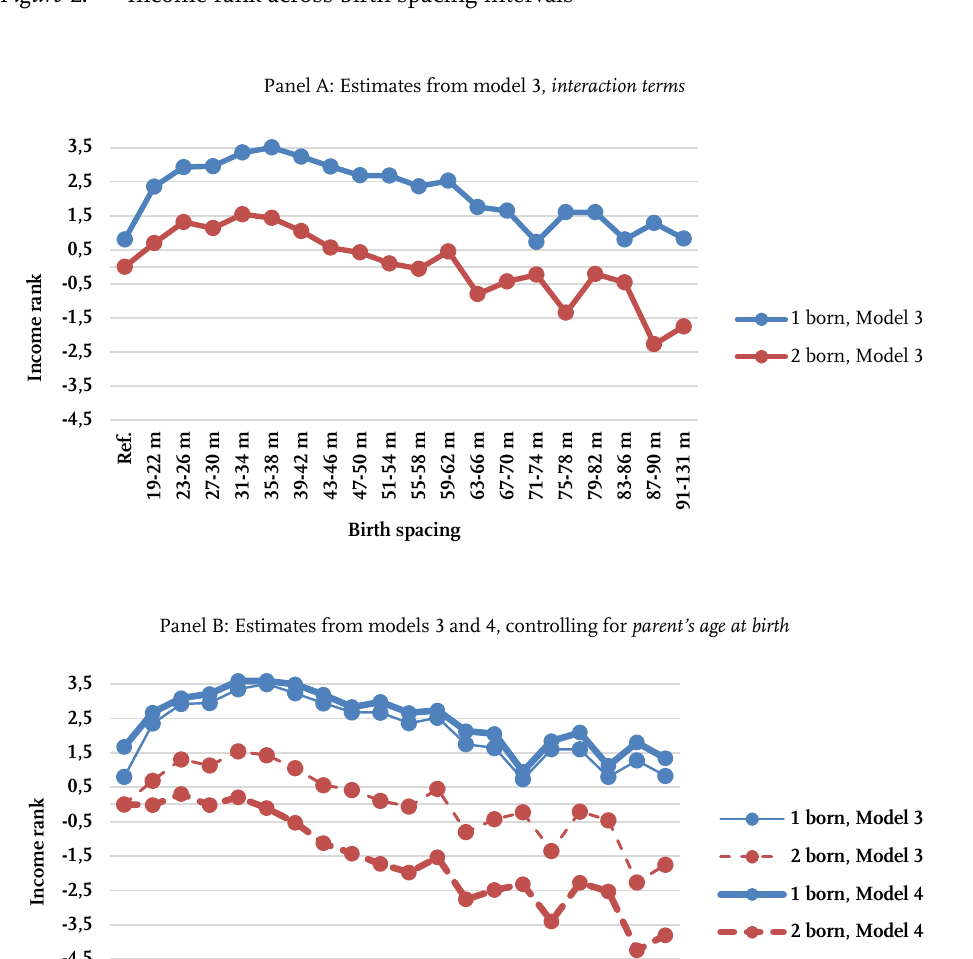
Figure 2 : Income rank across birth spacing intervals